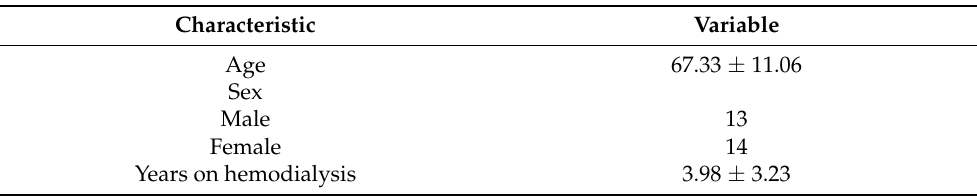
Table 1. Baseline characteristics of hemodialysis patients (mean ± SD).